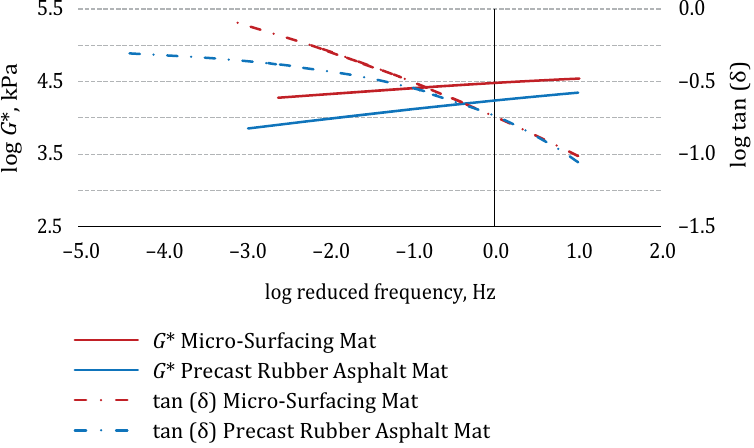
Figure 11. Master curve G surface